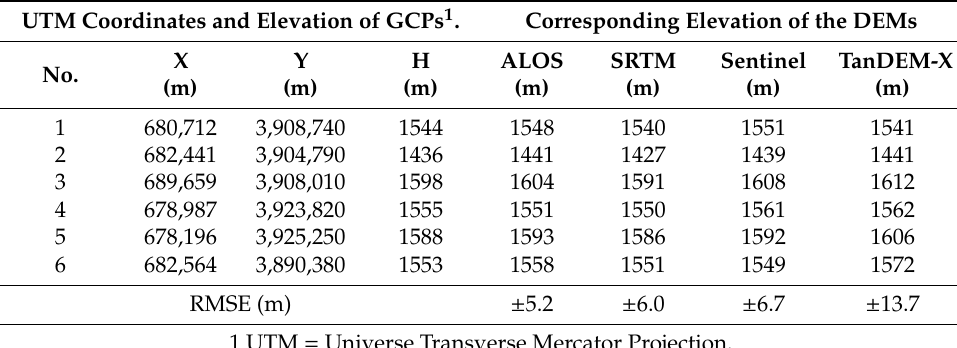
Table 4. Validation of the Digital elevation model (DEM) using GCPs (Iran). UTM Coordinates and Elevation of GCPs 1 .